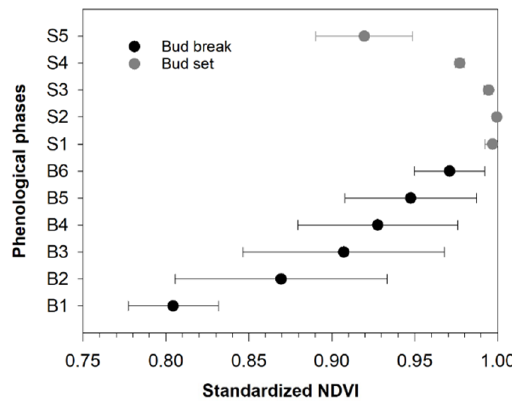
Figure 3. Correspondence between phenological phases measured in the field and mean standardized MODIS NDVI values of black spruce stands used for model calibration ( n = 40). Dots and error bars represent mean and standard deviation, respectively, for the three years used for calibration.